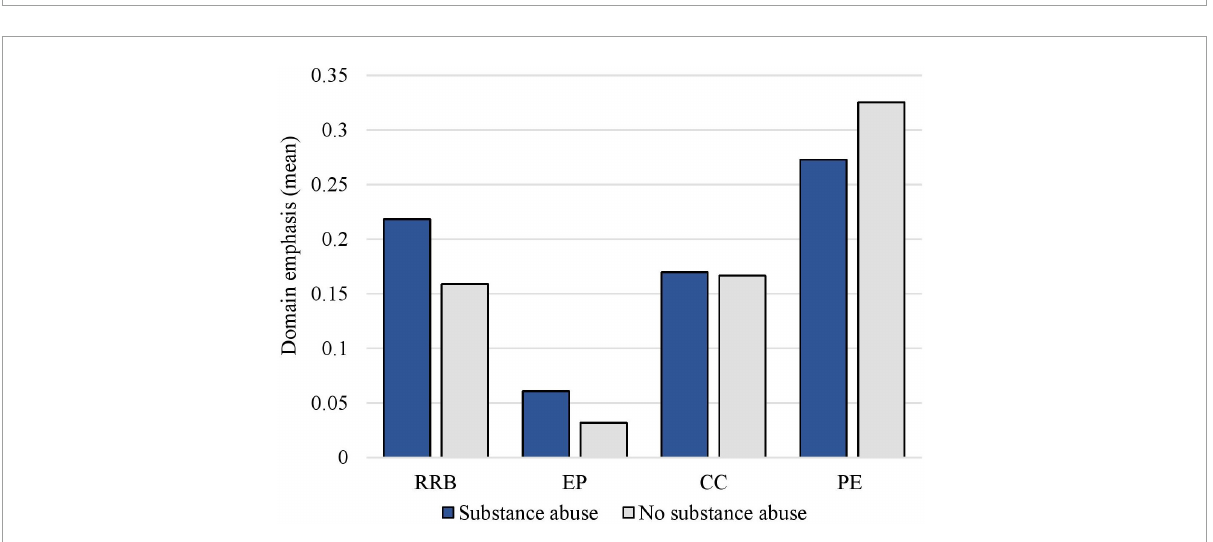
FIGURE2 The interrogators’ use of domains with suspects showing signs of substance use disorder versus not. RRB, rapport and relationship building; EP, emotion provocation; CC, confrontation/competition; PE, presentation of evidence. The domain emphasis scale ranged from 0 to 2